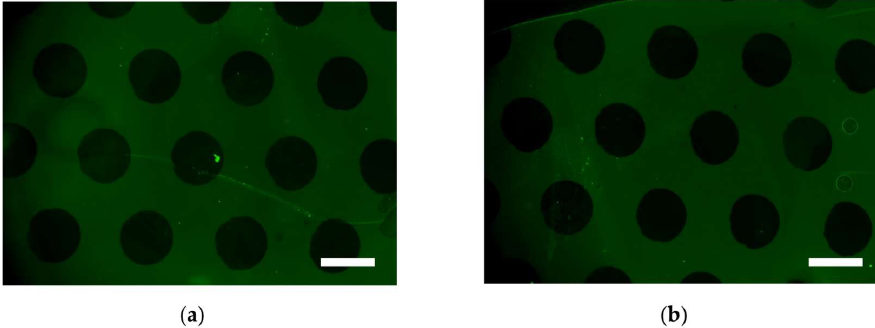
Figure 5. Fluorescence microscopy images of ( a ) AzPEG 350 [10]– and ( b ) AzPEG 750 [5]–coated micro- patterned polystyrene plates after the adsorption of Alexa488-conjugated IgG. Scale bars: 500 µm.